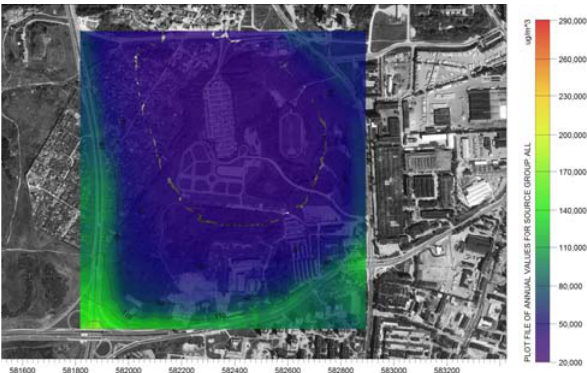
Fig 6 . Graphic view of pollutant dispersion